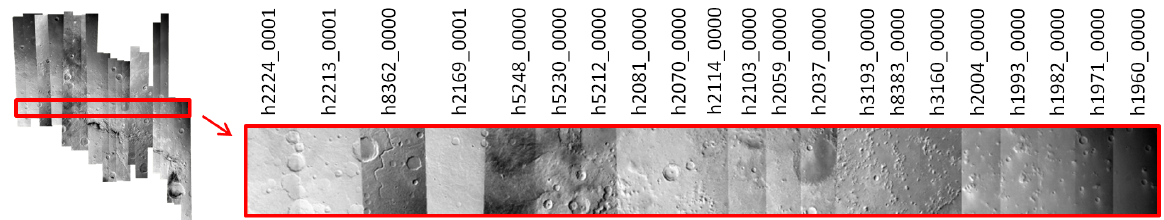
Figure 9: Illumination differences in the orthoimage mosaic rectified with the block adjusted orientation data and the HRSC DTM